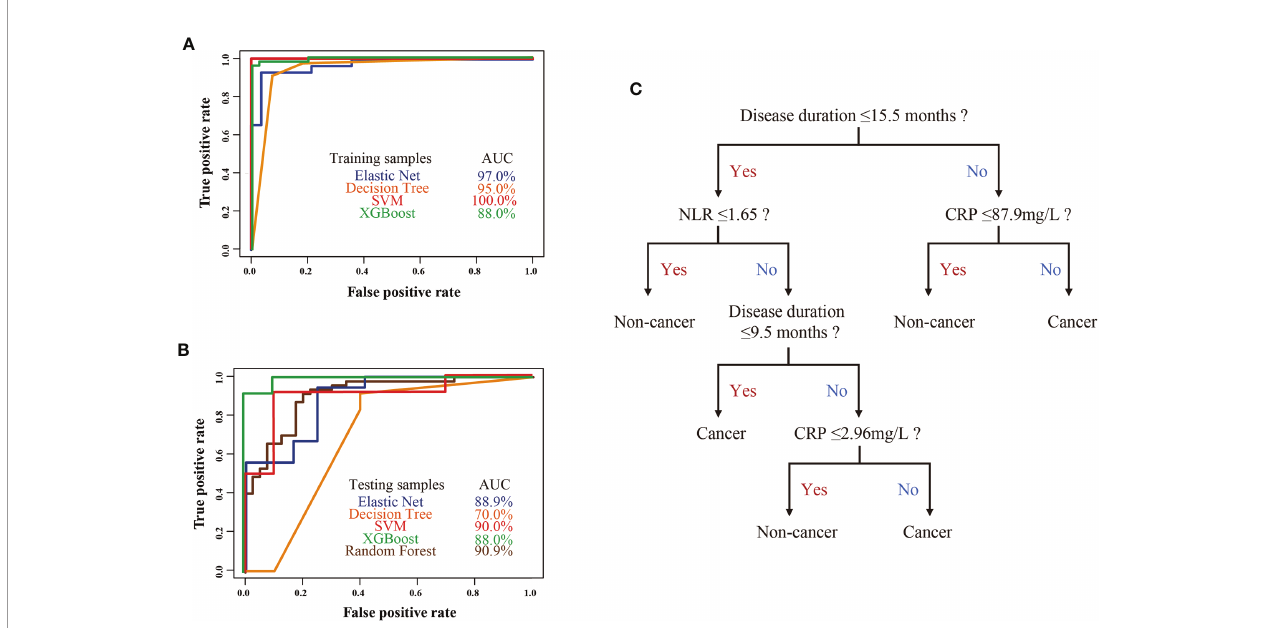
FIGURE 4 | (A) The ROC curves of four machine learning models in the anti-TIF1 g + myositis training samples. (B) The ROC curves of four machine learning models (elastic net, decision tree, SVM, XGBoost) in the anti-TIF1 g + myositis testing samples and random forest model in all patient samples. (C) Decision tree model showed disease duration, CRP, and NLR as important clinical features in the prediction of cancer in anti-TIF1 g + myositis